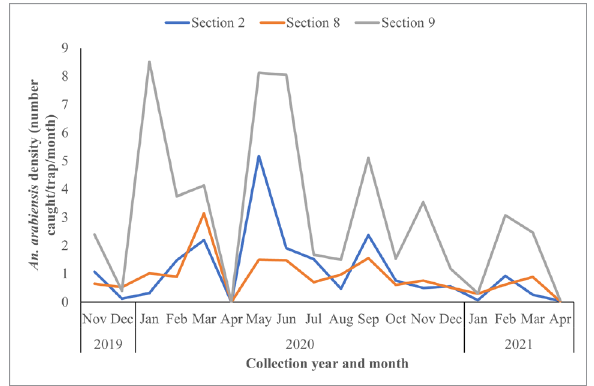
Mean number of Anopheles arabiensis collected per clay pot/ month from Mamfene, northern KwaZulu-Natal, South Africa, November 2019 to April 2021, stratified by section.